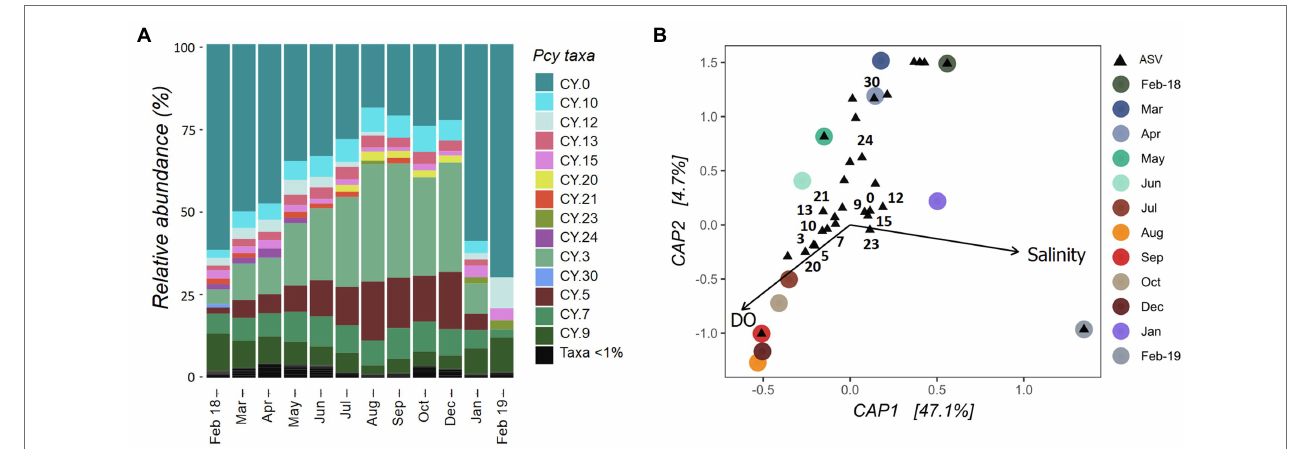
FIGURE 7 | Lake Ellesmere/Te Waihora picocyanobacterial community from February 2018 to February 2019. (A) Relative abundance of picocyanobacterial amplicon sequence variants (ASVs) with rare ASVs (<1% total abundance per sample) grouped together. (B) canonical analyses of principal coordinates (CAP) ordination showing picocyanobacterial communities sampled each month (circles) with ASVs (black triangles), constrained by selected environmental variables. Abundant ASVs as shown in (A) are numbered (B) . Pcy, picocyanobacteria and DO, dissolved